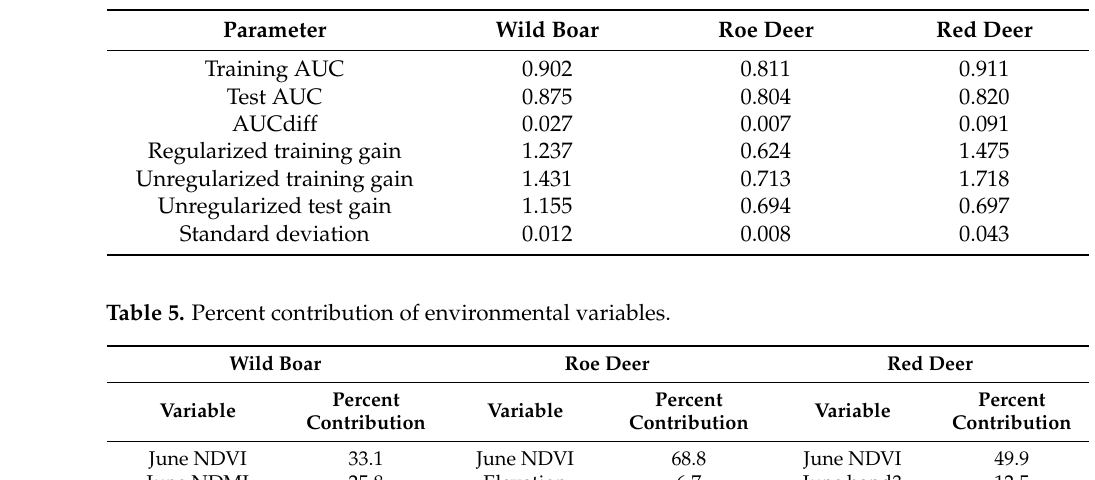
Table 4. ROC curve (receiver operating characteristic curve) verification of three ungulates with MaxEnt prediction.